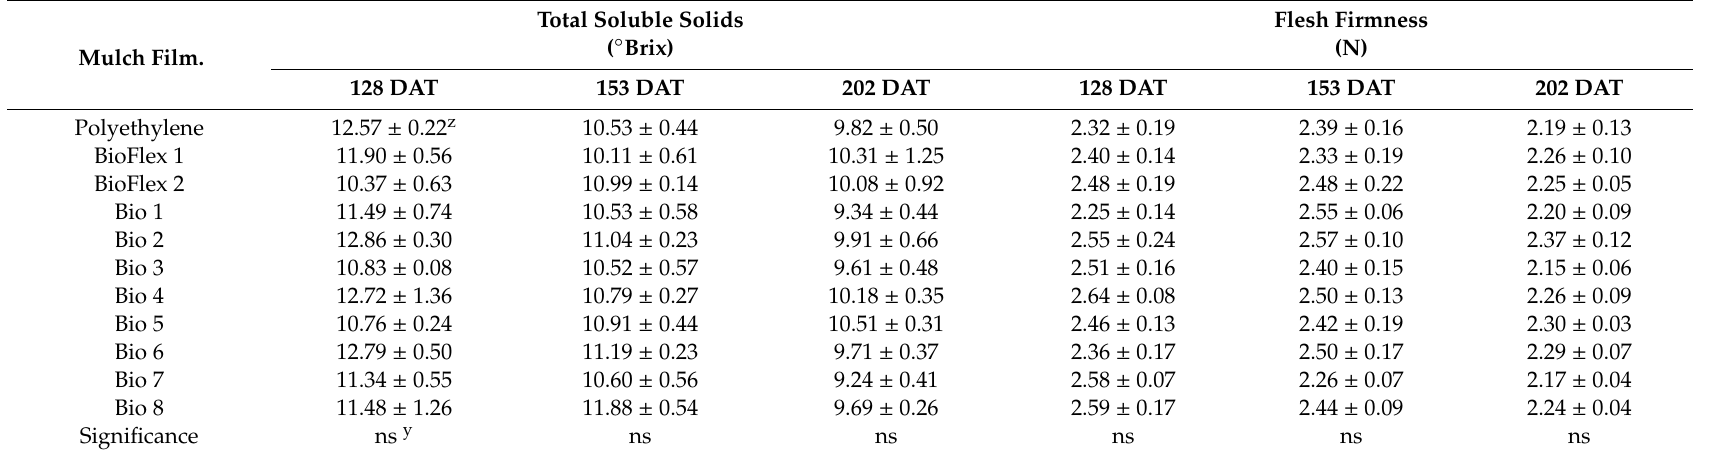
Table 3. E ff ects of di ff erent mulch films on total soluble solids ( ◦ Brix) and flesh firmness (N) of greenhouse strawberry fruit harvested at 128, 153, and 202 days after transplant (DAT).